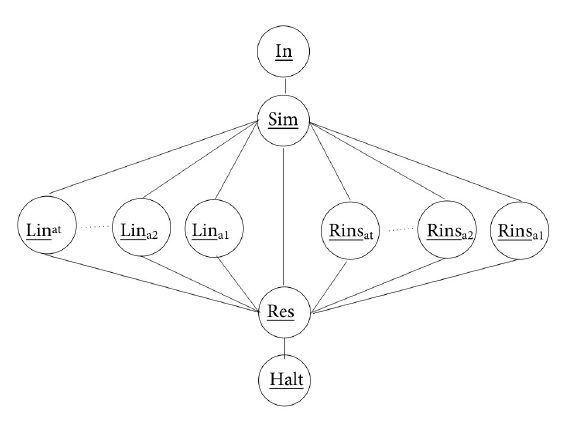
Figure 1. Communicating underlying